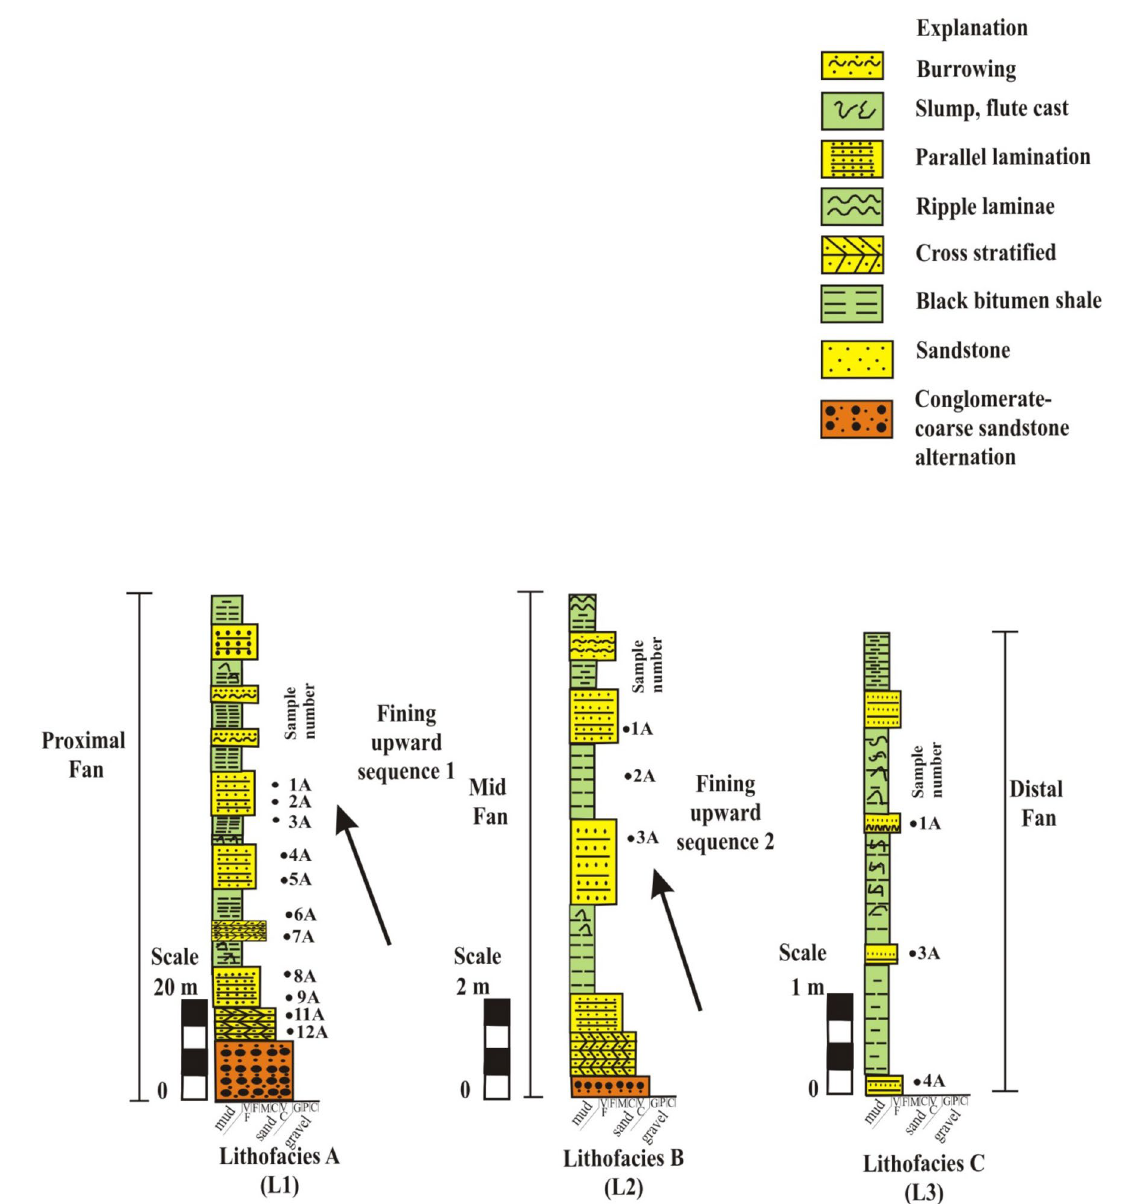
Fig. 5 Measured stratigraphic sections of the Haymana